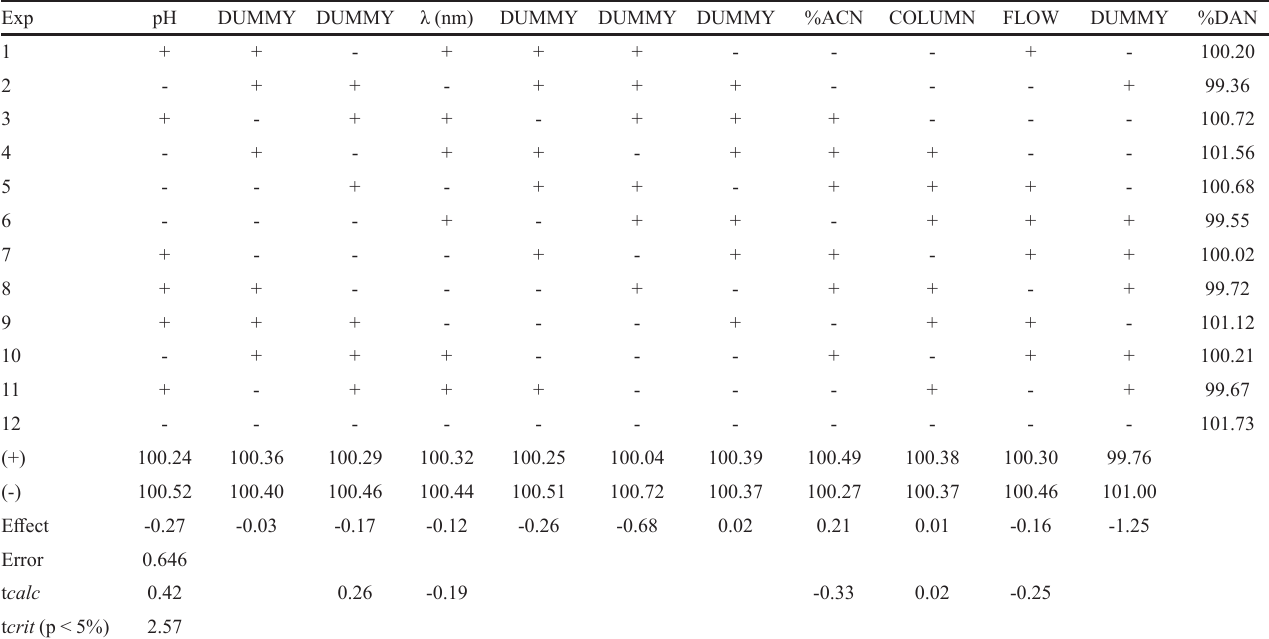
TABLE I - Plackett-Burmann experimental design to evaluate the robustness of the analytical